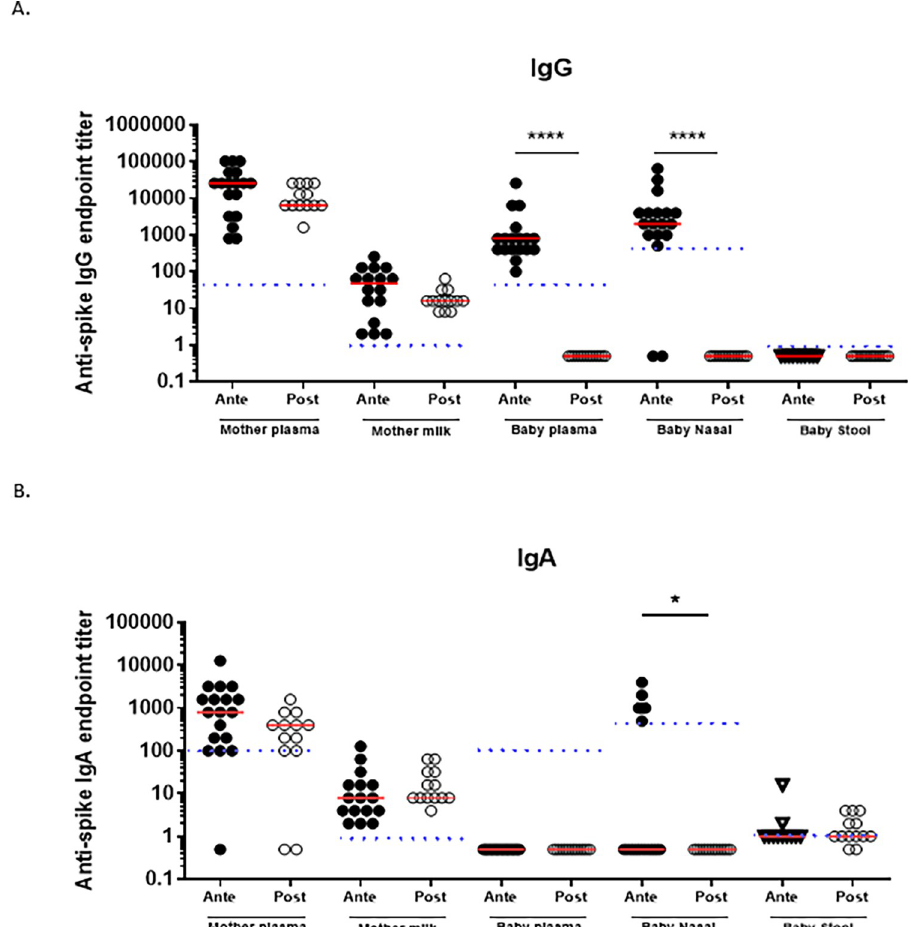
Fig 1. SARS-CoV-2 spike binding titers in vaccinated mothers and infants. A) Log anti-spike IgG binding titer in mother plasma, breast milk, infant plasma, infant nose, and infant stool. Samples below the limited of detection were given an arbitrary value of 0.5. Horizontal red lines represent median values. B) Log anti-spike IgA binding titer in mother plasma, breast milk, infant plasma, infant nose, infant stool. Samples below the limited of detection were given an arbitrary value of 0.5. Horizontal red lines represent medians values, and dotted lines the limit of detection. All ELISAs were designed to detect SARS-CoV-2 spike trimer, samples run in duplicate, and all results reported as endpoint titers. Nasal anti-spike IgG and IgA endpoint titers are reported here as direct results (without providing a ratio with total nasal IgG or IgA). Differences between groups were tested by the 2-tailed Fisher’s exact test, with a P � 0.05 being considered significant. * = P � 0.05; ** = P � 0.01; *** = P � 0.001; **** = P �